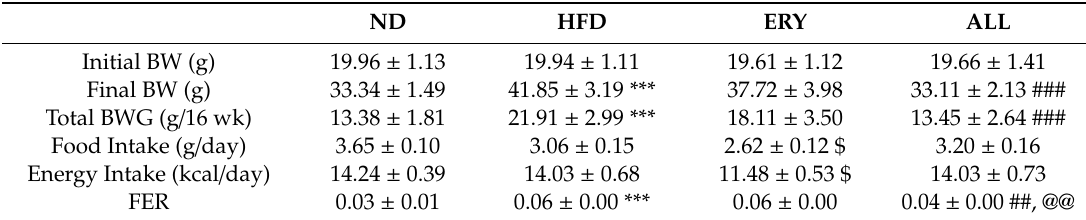
Table 1. E ff ects of D-allulose supplements for 16 weeks on body weight, body weight gain, food